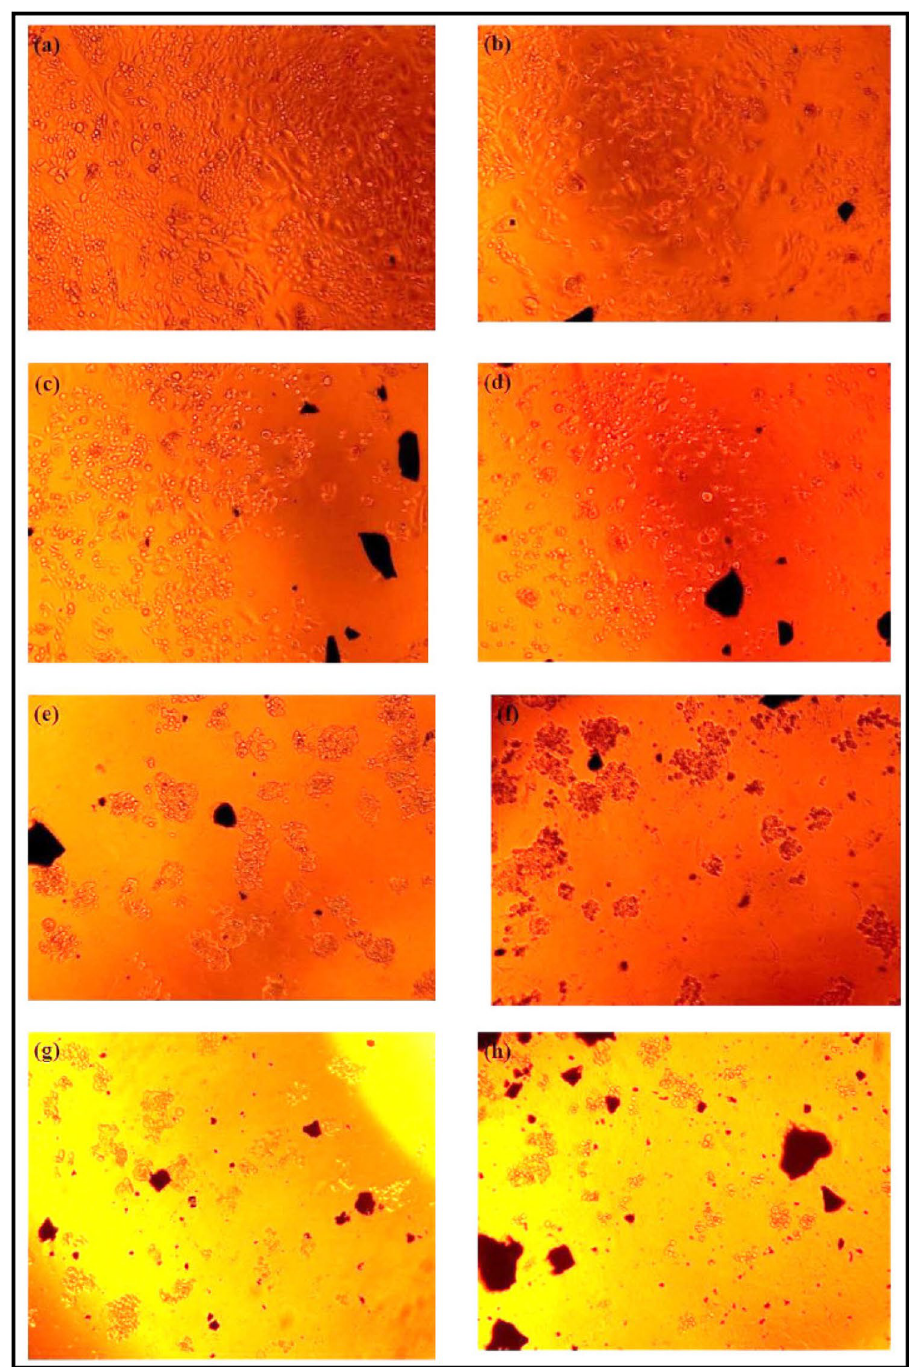
Figure 13. Cytotoxicity Images of mCdS@HPEc-g-PANi ( a ) (60 μg/ml, ( b ) 125 μg/ml, ( c )250 μg/ml, ( d ) 500 μg/ml on PC3 and CdS@HPEc-g-PANi ( e ) 60 μg/ml, ( f ) 125 μg/ml, ( g ) 250 μg/ml, ( h ) 500 μg/ml on